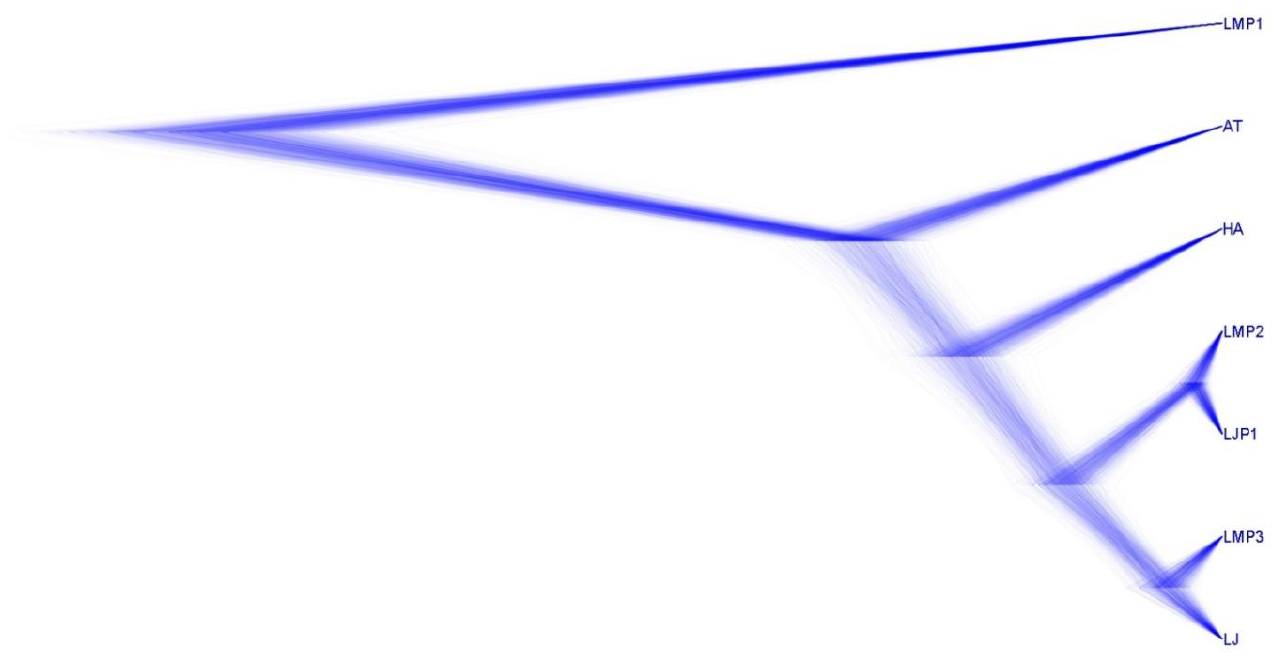
Figure 2. Alignment of known and predicted EPSP synthase protein sequences. Sequences are identified by species name. Proteins predicted through sequence homology are named as “putative”.